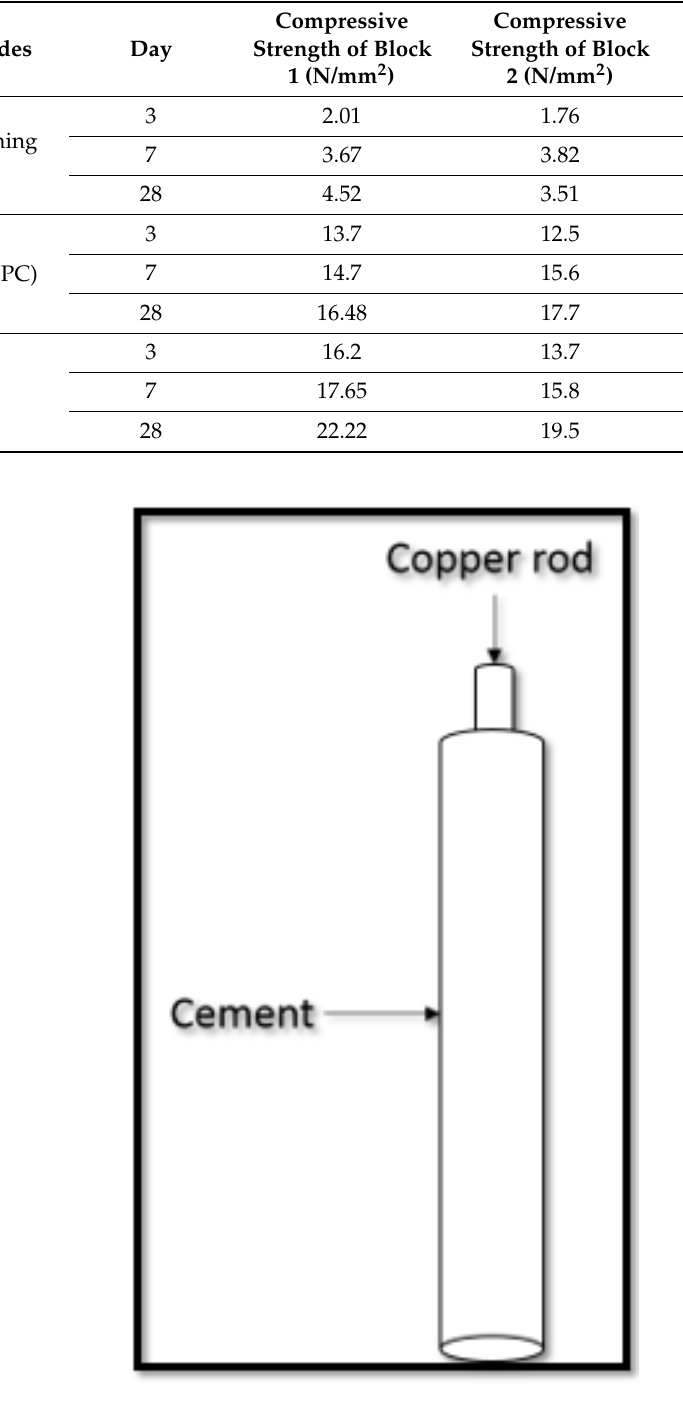
Figure 1. Spiked strip ground electrode.